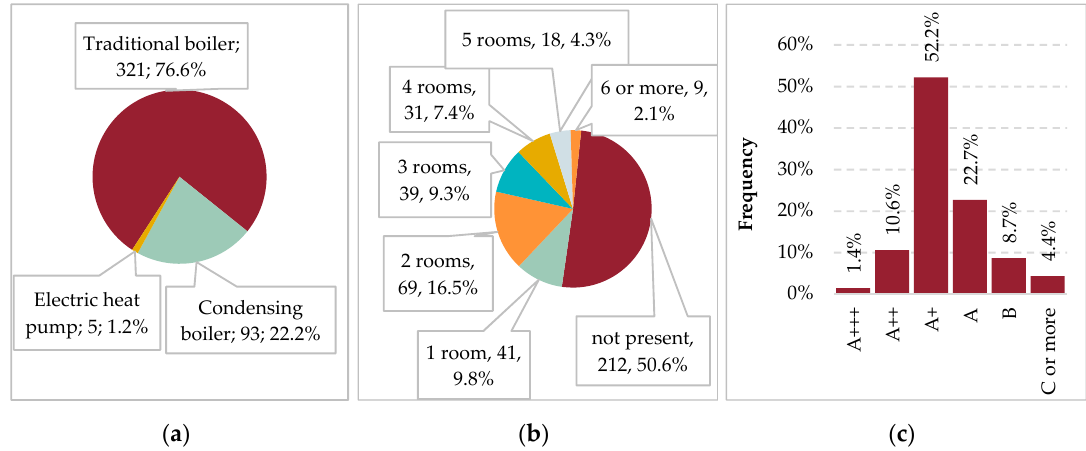
Figure 5. Equipment: ( a ) Heating systems typology; ( b ) chilled rooms; ( c ) energy label of cooling system.